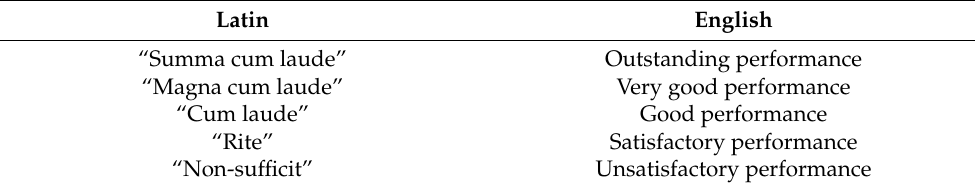
Table 2. Possible overall grades for German postgraduate doctoral